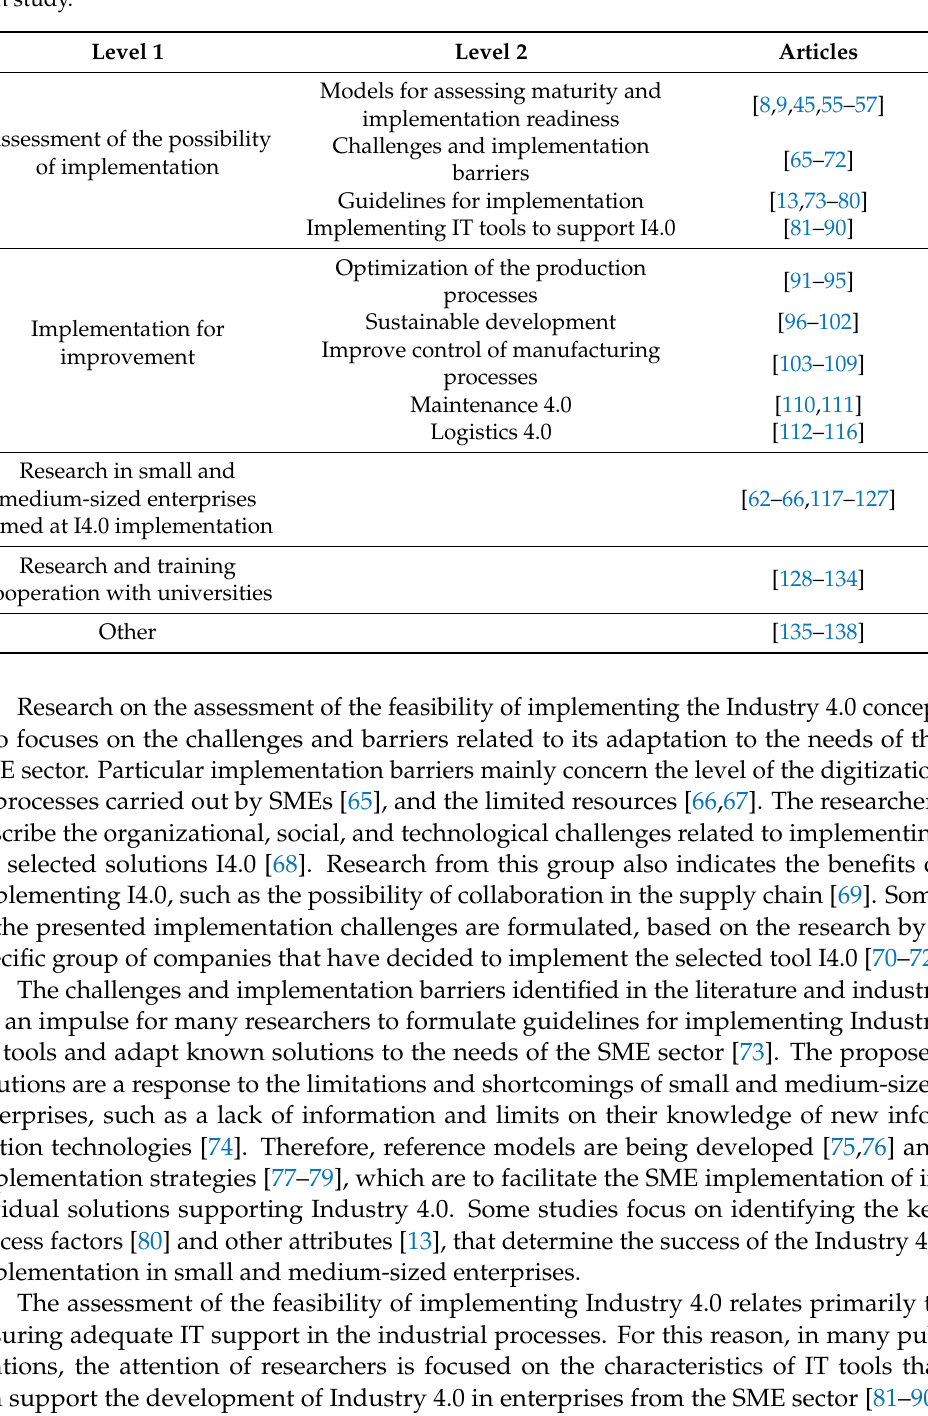
Table 9. The results of classifying the analyzed articles on Industry 4.0 in the SME sector. Source: own